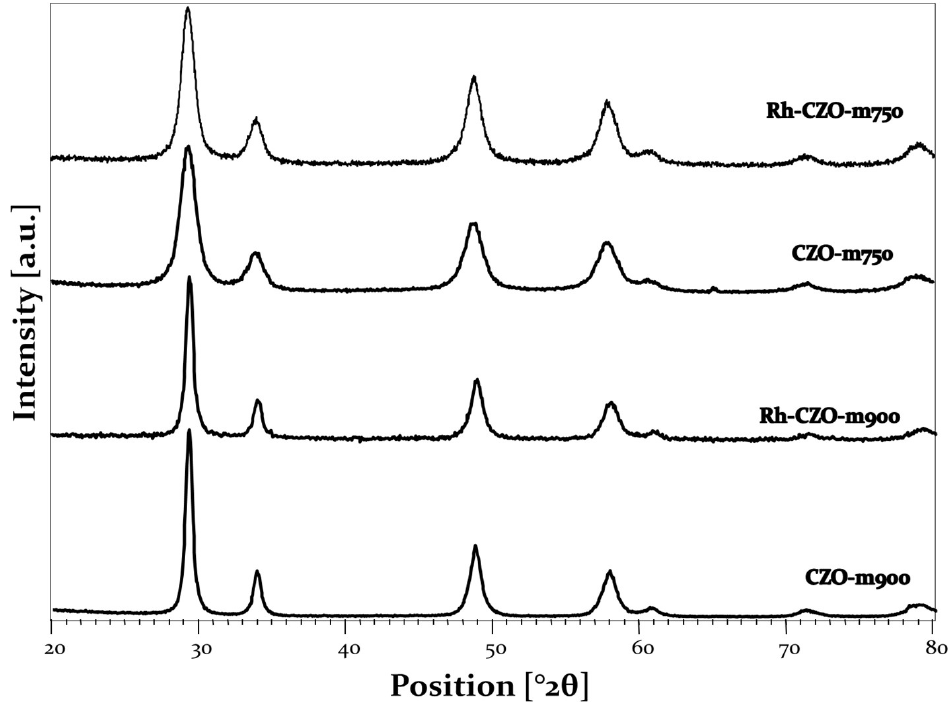
Figure 1. XRD analysis of (from top to bottom) Rh-CZO-m750, CZO-m750, Rh-CZO-m900 and CZO- m900.